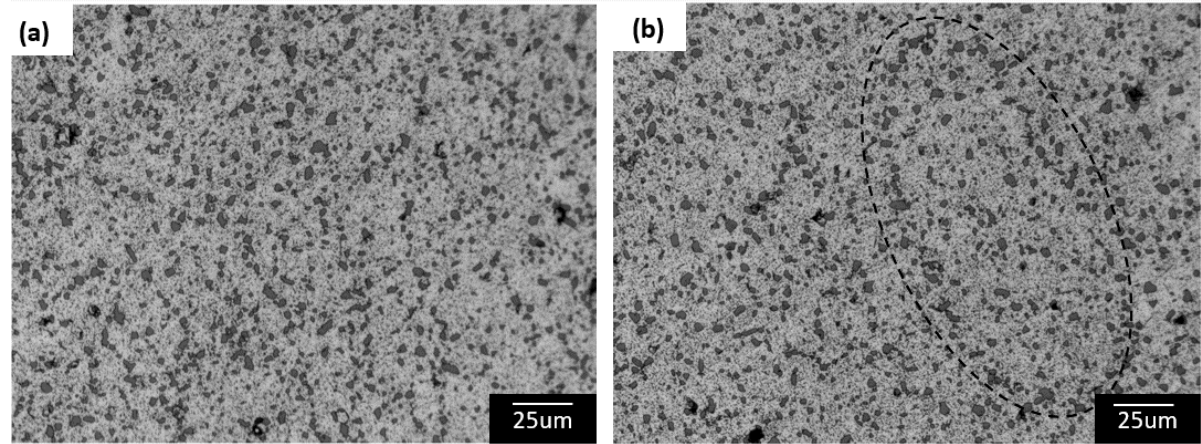
Figure 3. Optical micrographs of specimen ST for 6 h; ( a ) longitudinal section; ( b ) transverse section.